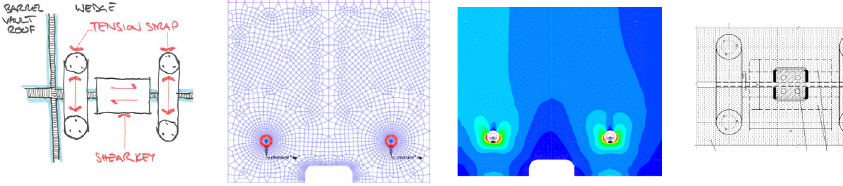
Figure 16: Forces from the global model are extracted, connection concepts are developed and applied to detailed models showing local stress concentrations which dictate final connection design The example above shows a combination of shear and tension forces to be transferred on the bottom edge of the